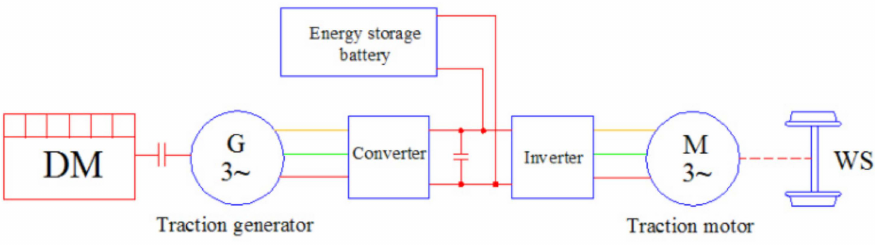
Figure 2. The regenerative braking process in the diesel–electric train